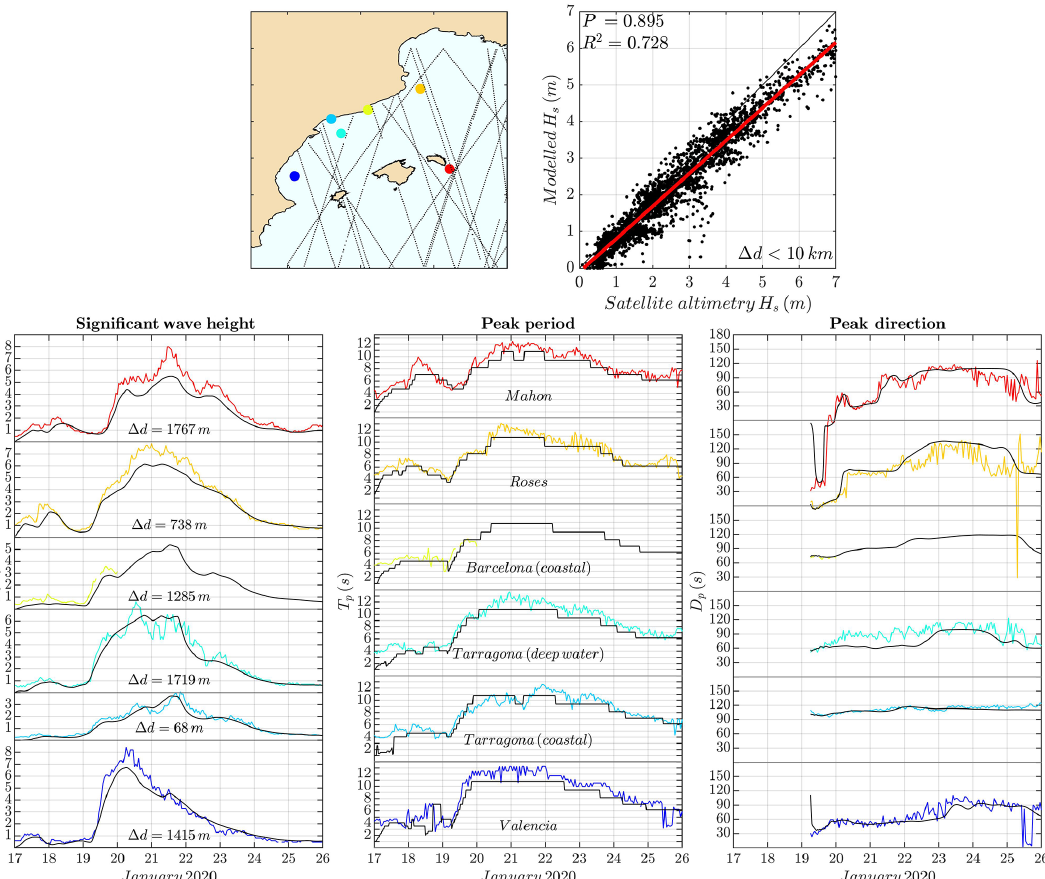
Figure 3. Comparison between modelled (black line) and observed (coloured lines; each colour corresponds to one location on the map) wave parameters during the storm. Note that wave direction before 19 / 01 is not used because of the low confidence with very small waves. The upper right panel shows the comparison between the modelled significant wave height and the satellite-measured one at the same location (satellite tracks are indicated by black lines on the map) and time. (cid:49)d indicates the distance between observations and the closest grid point used for